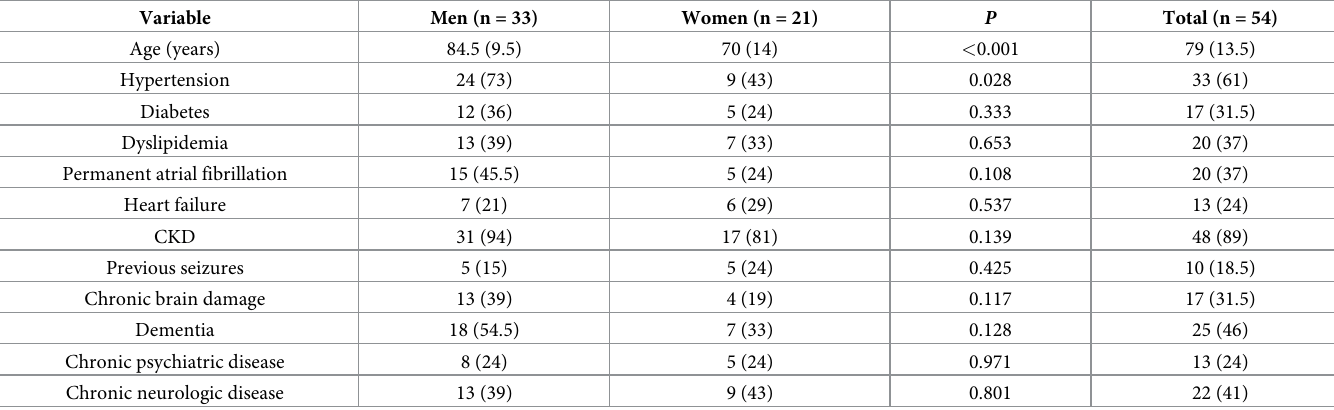
Table 1. Baseline characteristics and comparison regarding